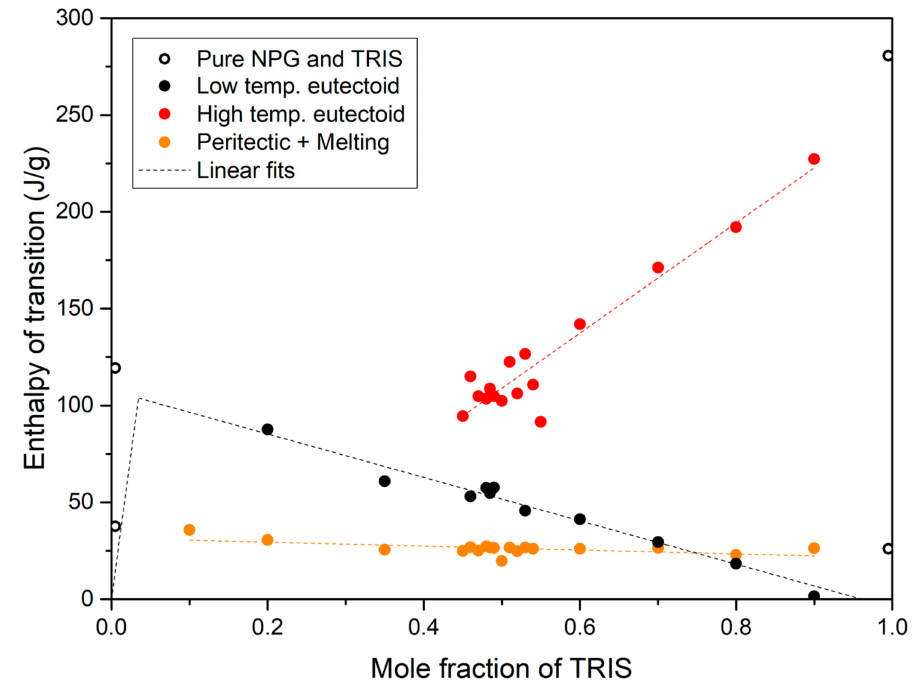
Figure 5. Enthalpy changes related to the di ff erent transitions in the NPG-TRIS system: experimental data (symbols) and calculated linear trends (discontinuous